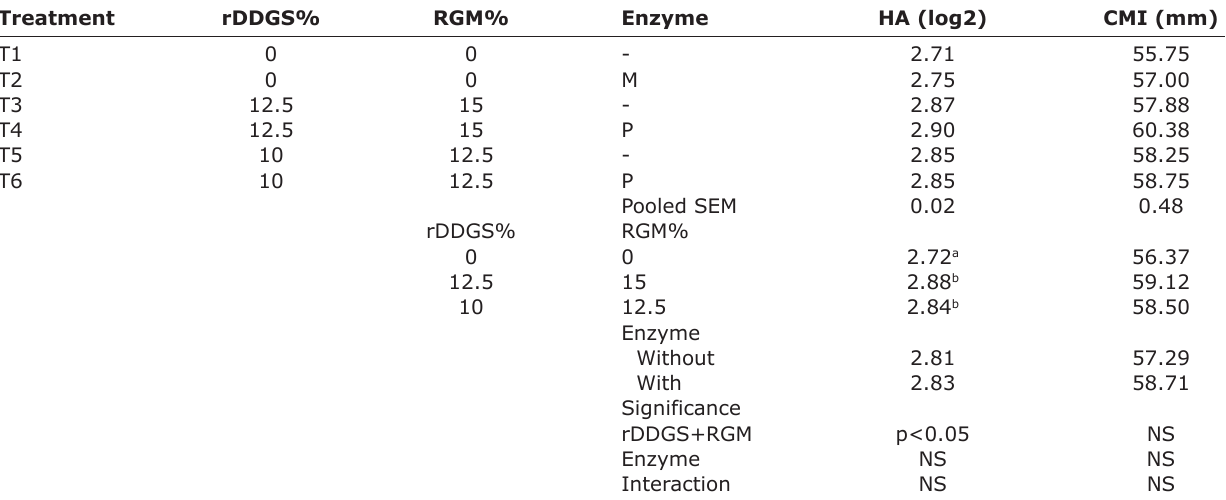
Table-2: Effect of feeding different levels of rDDGS and RGM combinations on immunological parameters. Treatment